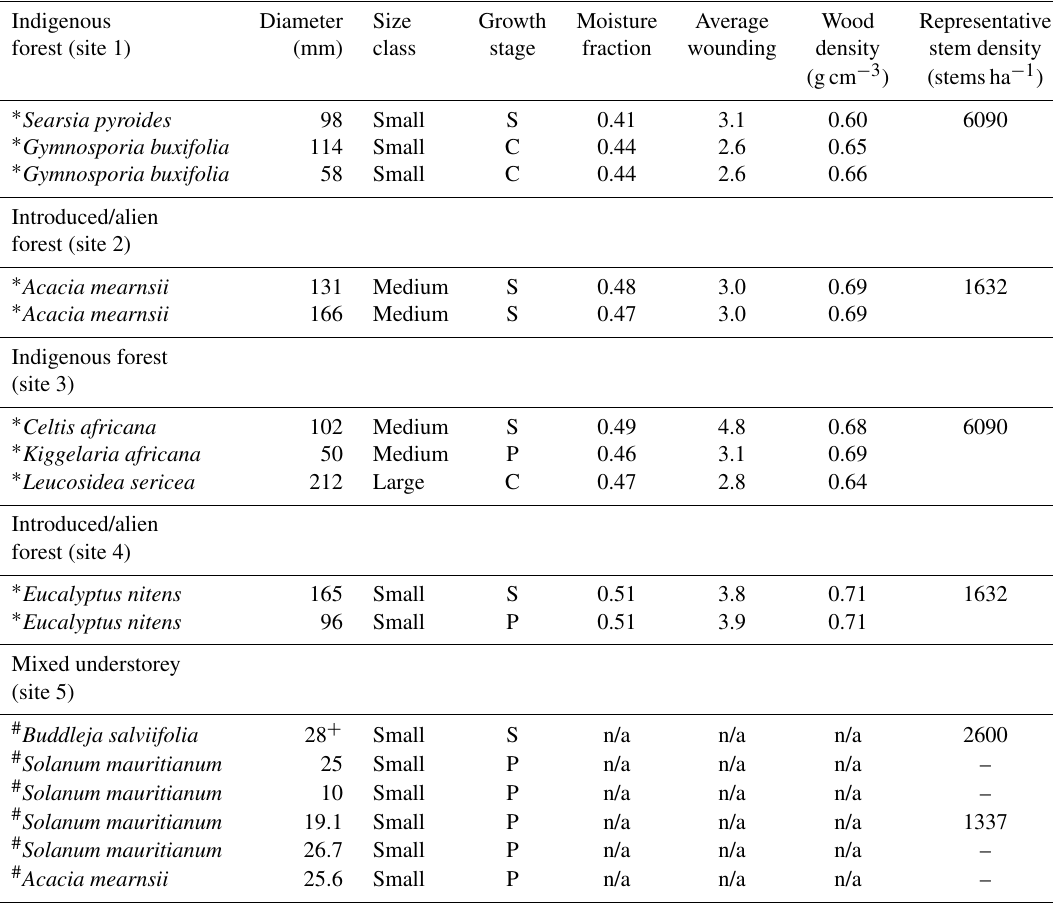
∗ indicates that the HPV technique was used and # indicates that the stem steady state (SSS) technique was used. + indicates average stem diameter for multi-stemmed trees. Growth stage is represented by primary (P), secondary (S) or climax (C). n/a indicates that the measurement parameter was not applicable for the technique